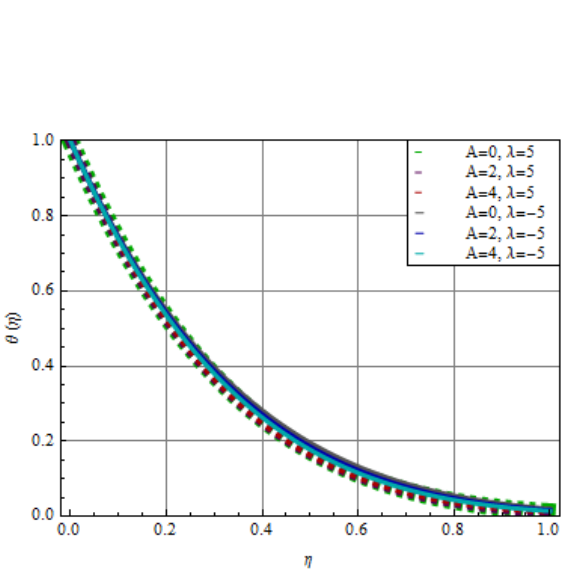
Fig. 8: The temperature distribution for alumina-sodium alginate nanofluid for different values of mixed convection and unstediness parameters with M = 1, U = 0.5, ε = 0, Pr = 6.2, ϕ = w